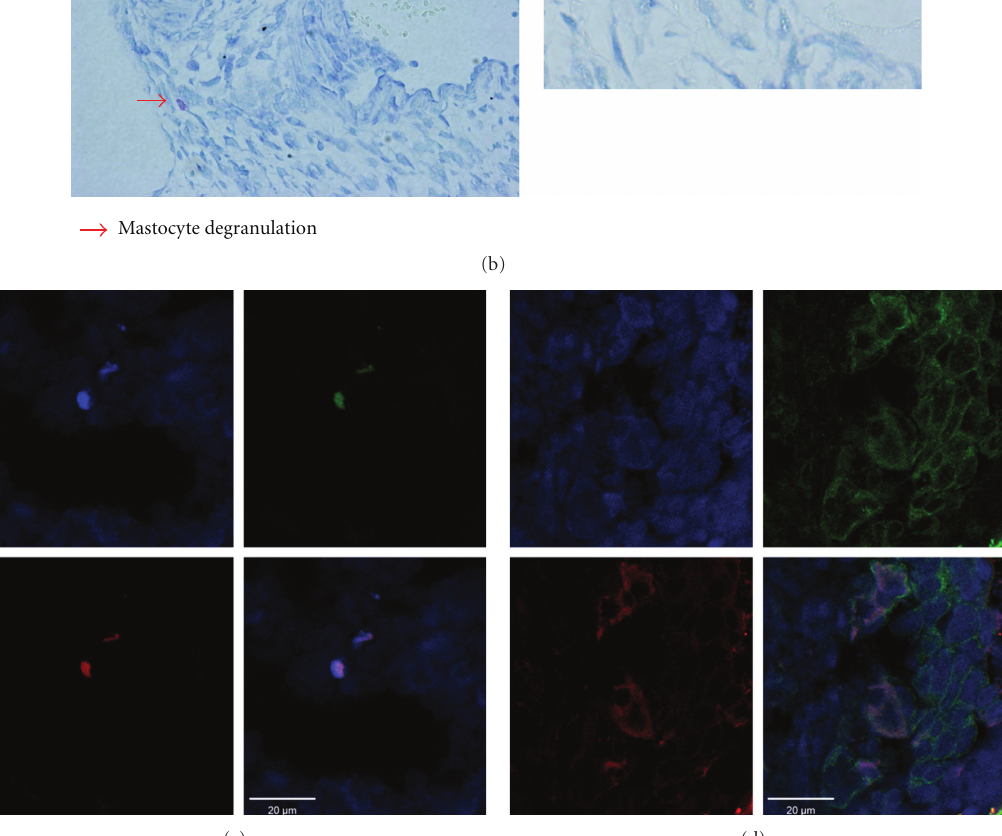
Figure 3: LPS-induced degranulation of mast cells. (a) Control group ( n = 3); (b) Model group ( n = 6). The mast cells with or without degranulation are indicated with red or blue arrows, respectively. Double-labeled immunofluorescence microscopy showing MCP- 1 interactions with mast cells in bladder tissues. (c) Control group ( n = 3); (d) Model group ( n = 6). Nuclei are colored blue by DAPI; green fluorescence indicates MCP-1 protein immunostaining; red fluorescence indicates MC immunostaining. Scale bars in the immunofluorescence images represent 20 μ